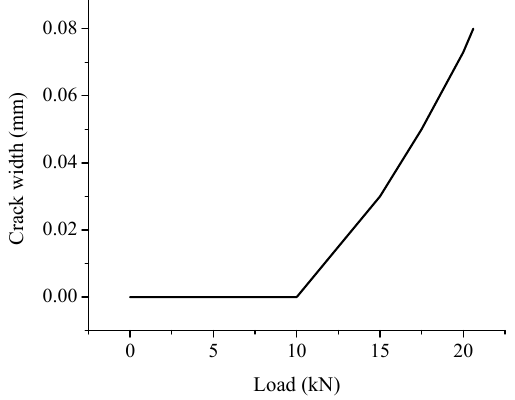
Figure 17. Crack width versus load.